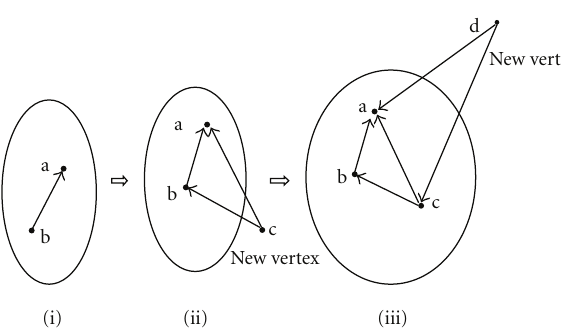
Figure 1: Henneberg construction for making leader-follower type formation from four agents “a”, “b”, “c”, and “d” (i) “a”, “b” are initial vertices with one edge directed towards “a” (leader) from “b” (first follower) (ii) “c” is new vertex added to (i) (iii) “d” is new vertex added to (b).